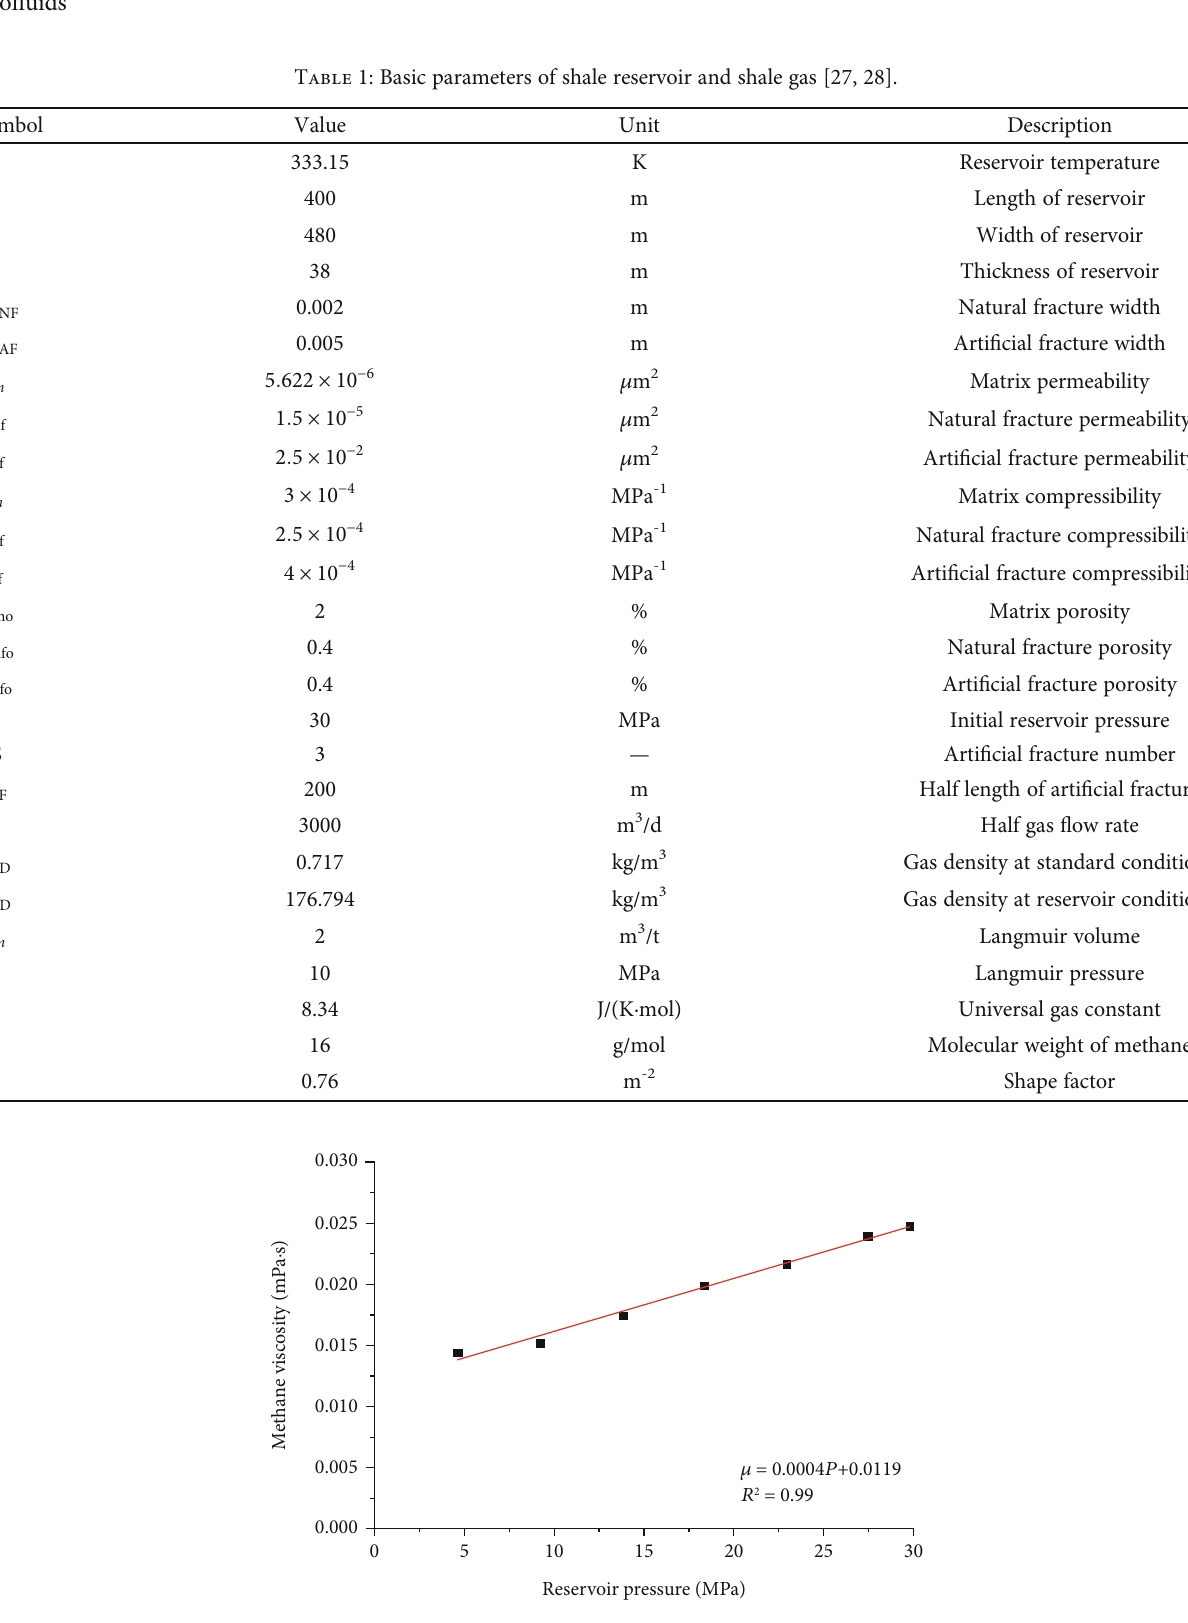
Figure 2: Viscosity of methane changes over